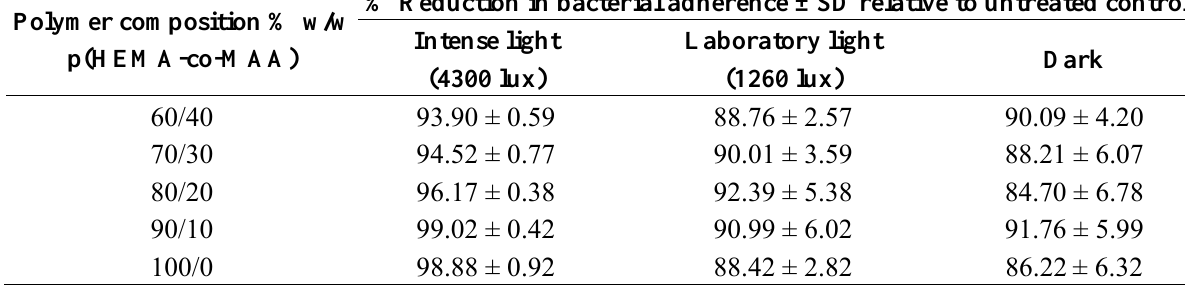
Table 1. Reduction in S. epidermidis adherence to p(HEMA-co-MAA) copolymers impregnated with a cationic porphyrin (tetrakis(4- N -methylpyridyl)porphyrin). Reproduced from reference [44] with permission of Elsevier.